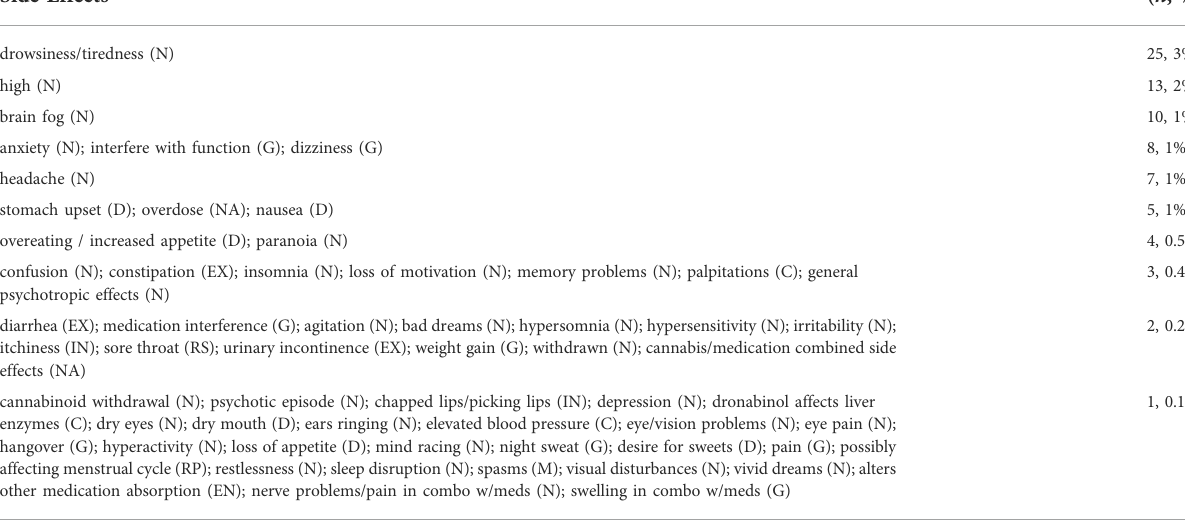
TABLE 3 Self-reported cannabis side effects classi fi ed by body system and prevalence. Side